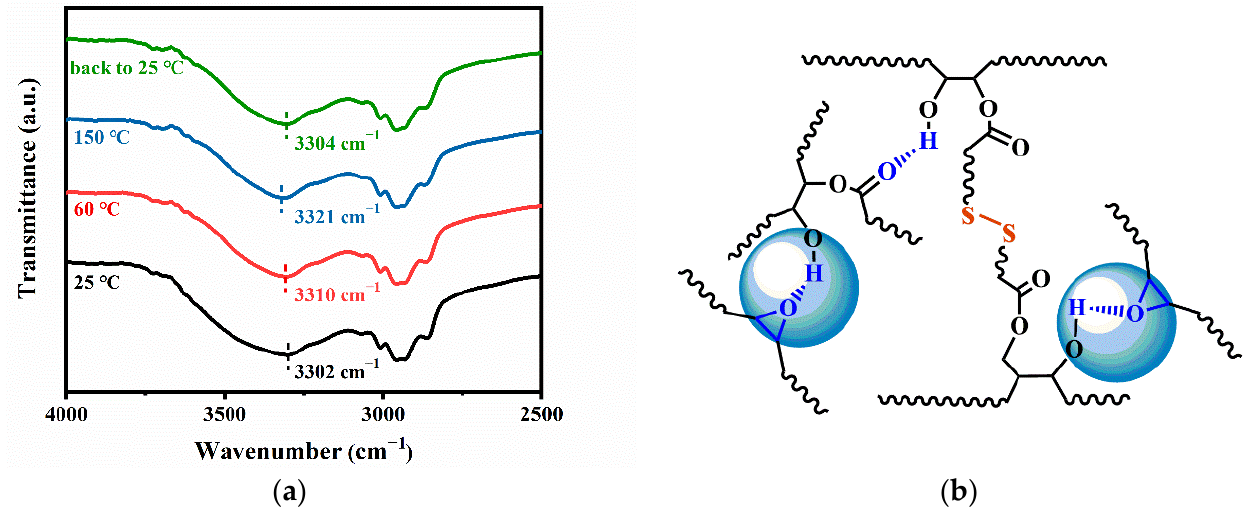
Figure 6. ( a ) FT-IR spectra of vitrimer 4 at different temperatures; ( b ) the illustration of hydrogen bonds in the network of PB vitrimers.